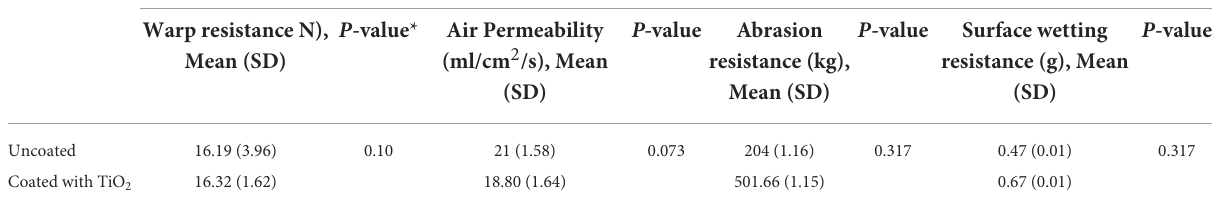
UPF values The UPF of uncoated and coated fabric by measuring the transfer rate (T) for UVR and its spectral results is shown in Figure 5. According to the results, the UPF value of the uncoated fabrics calculated via Equation 1 was 3.67 and the UPF value of fabrics coated with TiO 2 nanoparticles was 55.82, indicating the strong UV blocking ability of the coated fabrics. It was confirmed that the in-situ deposition of TiO 2 nanoparticles on fabric can provide adequate protection against